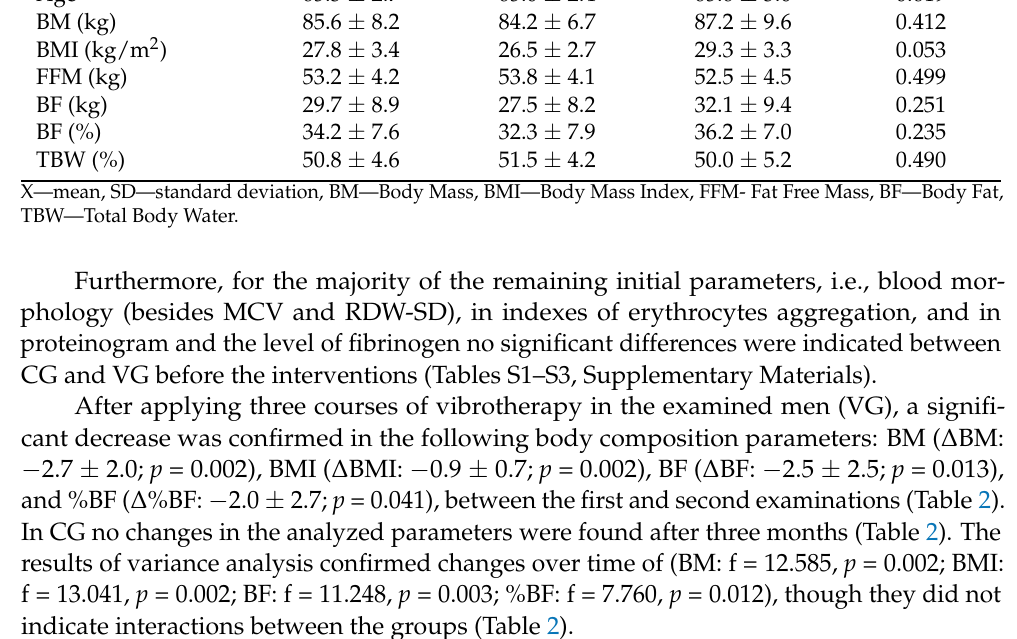
Table 2. Values of anthropometric parameters and their differences ( ∆ ) in the control (CG) and examined (VG) groups before and after three vibrotherapy series, considering interactions between the groups ( p int) and changes over time ( p time).